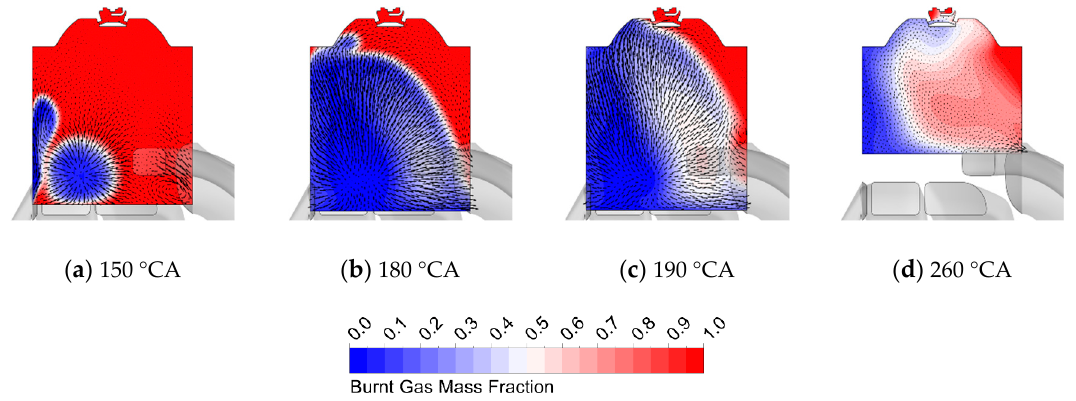
Figure 9. In-cylinder scavenging behavior at 7500 rpm and 30% of load using PN8 prechamber.